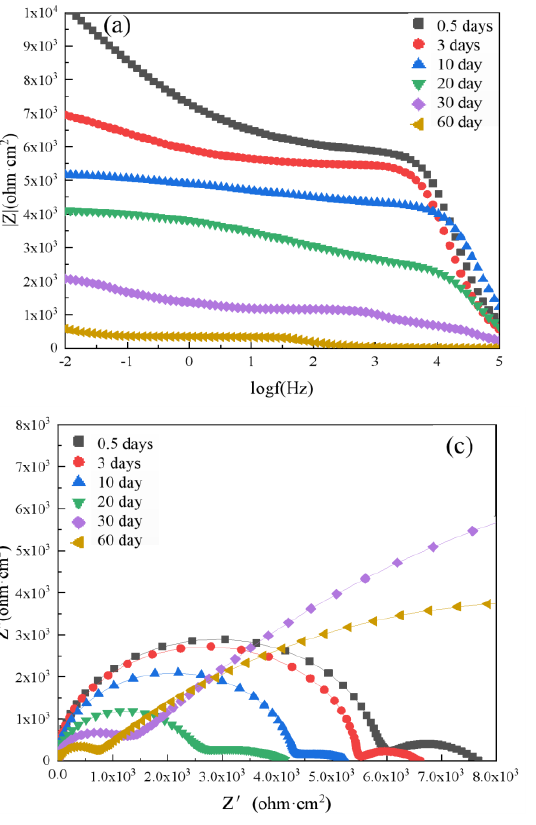
Figure 7. EIS results of unaged pure epoxy resin coating after immersion for various lengths of time in 3.5 wt.% NaCl solution: ( a ) Bode diagram, ( b ) phase angle diagram, and ( c ) Nyquist diagram.